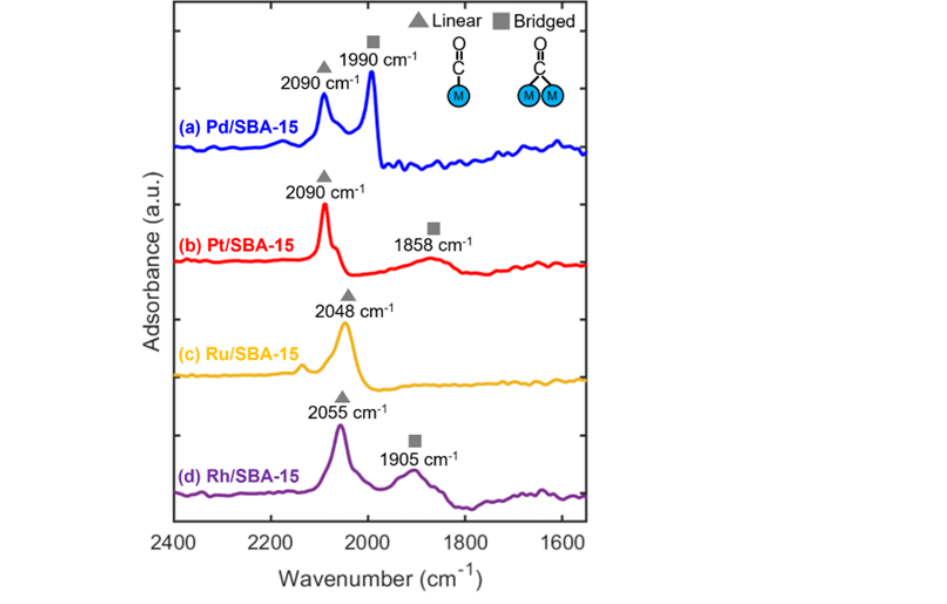
Silica is generally considered to be a weakly interacting support for most metal cata- lysts, and achieving and maintaining good dispersions with silica supports can sometimes be challenging [30]. To determine whether better dispersions might be achieved if the composition of the mesoporous walls were made of a different material, we deposited Pd onto SBA-15 that had been coated with 0.2 nm of ZrO 2 using ALD. The preparation of ZrO 2 /SBA-15 has been described in detail elsewhere [24]. The thickness of the film was determined from the mass of ZrO 2 added (48 wt%), assuming the ZrO 2 uniformly covered the SBA-15 pores with its bulk density. Previous work also revealed that the pores of ZrO 2 /SBA-15 were uniformly covered with ZrO 2 , using temperature-programmed desorption of 2-propanol and the fact that ZrO 2 is more acidic than silica [24]. A saturation exposure of ZrO 2 /SBA-15 to the Pd precursor resulted in a sample that had 5.1-wt% Pd, corresponding to a metal coverage of 1.2 × 10 18 metal atoms/m 2 . As discussed earlier, the higher Pd coverage on the Pd/ZrO 2 /SBA-15 compared to the Pd/SBA-15 may be due to a higher adsorption-site density.